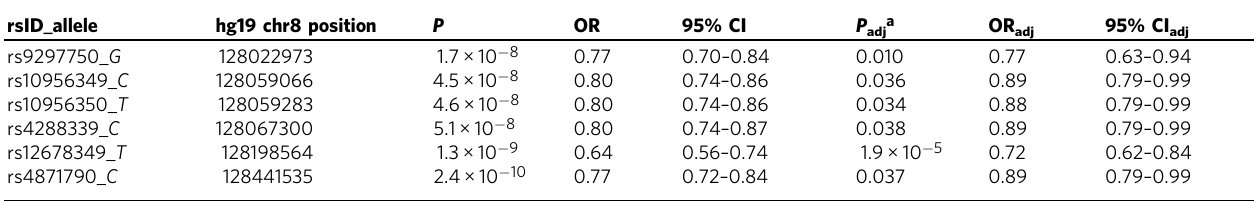
Table 2 Genome-wide signi fi cant variants associated with HPC among combined subjects, remaining signi fi cant under adjustment for previously known